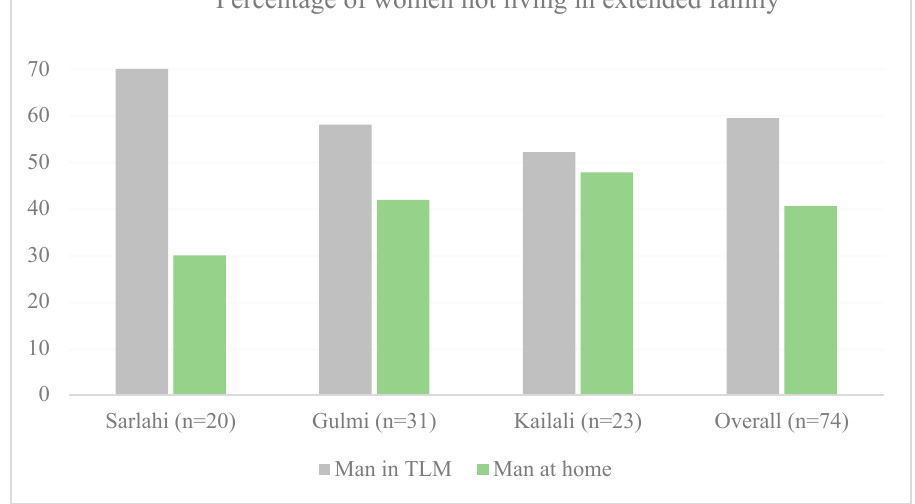
Figure 4. Percentage of women not living in an extended family.